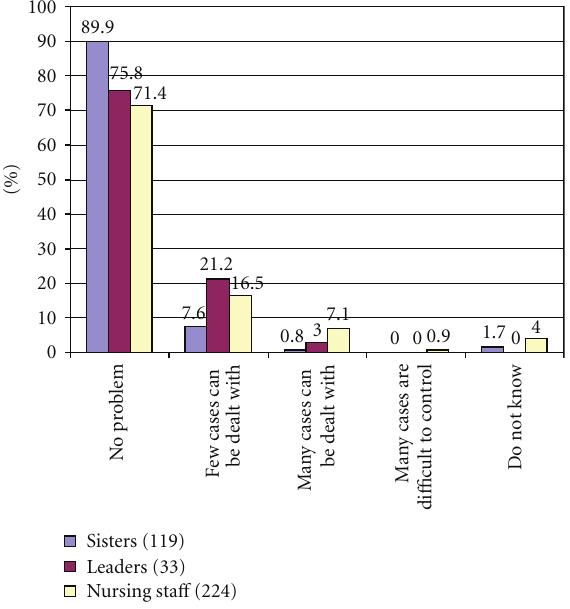
worked daytime, while nursing personnel worked on three- divided shift. Only 19% of the sta ff were nurses, 70% were without specific training in healthcare (students), and 32% had no formal healthcare education at